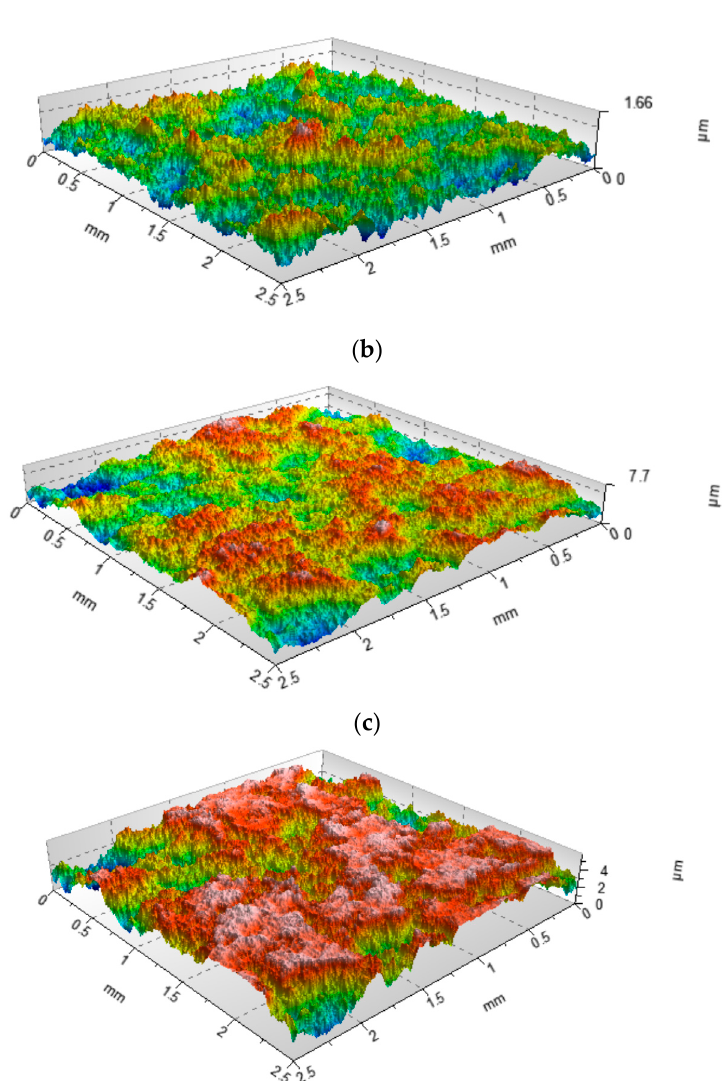
Figure 15. Example of generation of two-process random surface topography: the plateau surface: Sq = 0.21 µm, CL = 60 µm ( a ), the valley surface: Sq = 1.28 µm, CL = 170 µm ( b ), two-process surface: Spq = 0.21 µm, Svq = 1.28 µm, Smq = 79% ( c ).